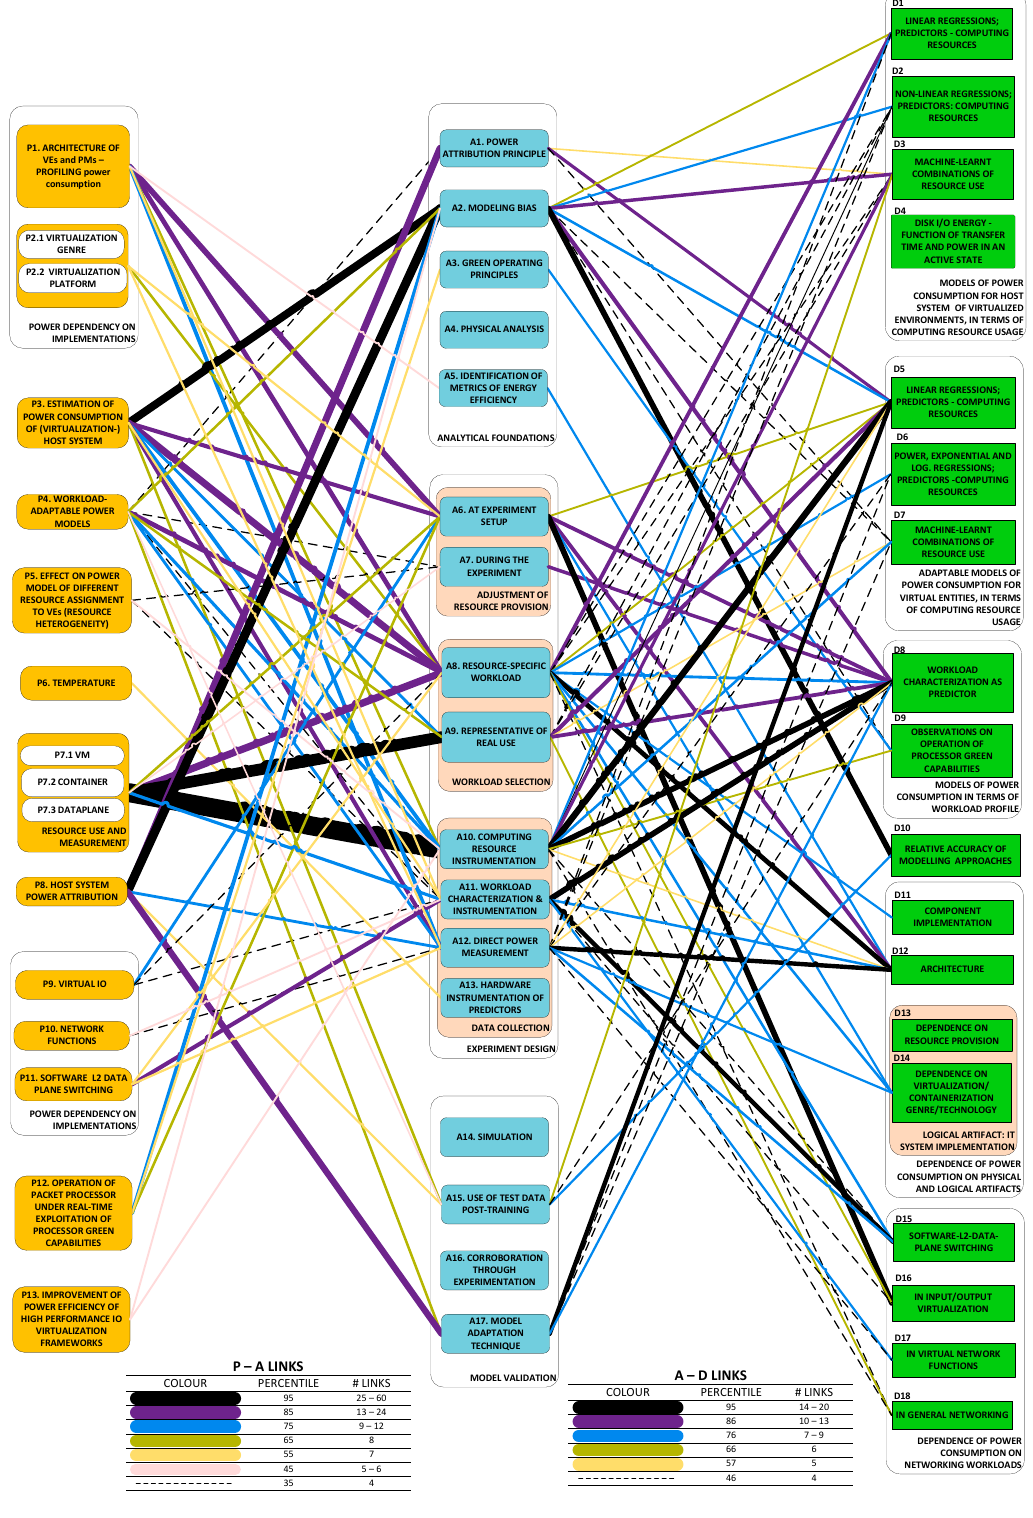
Figure 18. A directed acyclic graph showing the distribution of research into power measurement and power consumption models in virtualized networking and computing environments. D1 [57–